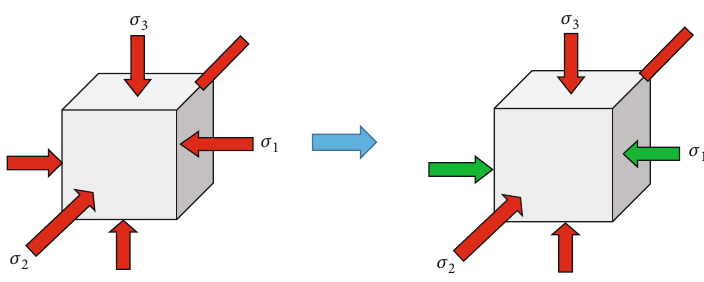
Figure 2: Loading and unloading 3D schematic (path 1).